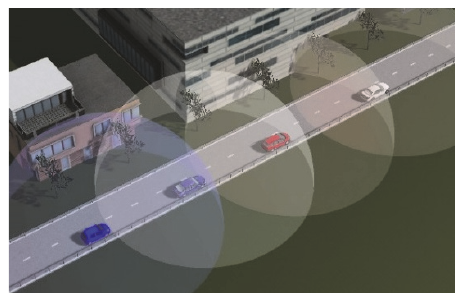
Figure 5: Virtual scenario of platoon driving in